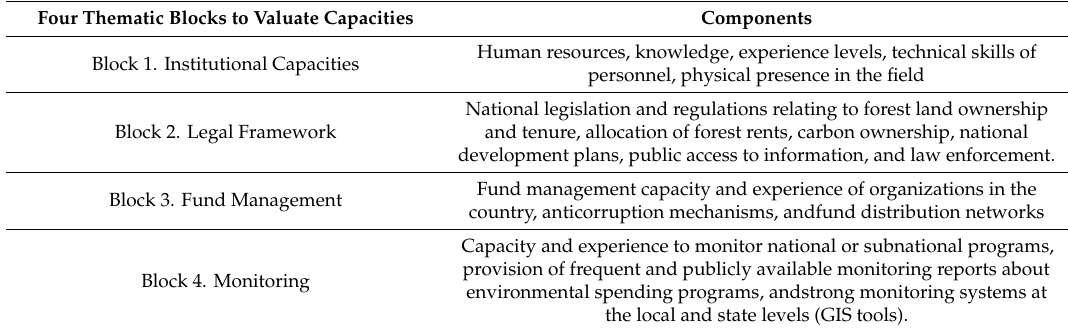
Table 1. Building blocks of the Options Assessment Framework (OAF) to valuate benefit-sharing capacities. Four Thematic Blocks to Valuate